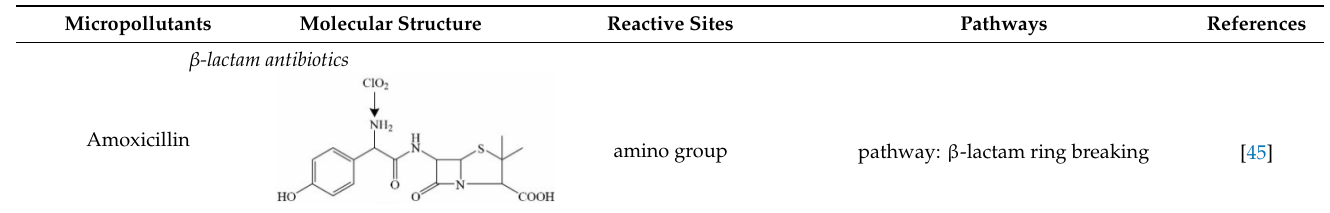
Table 2. Reactive sites and degradation pathways based on the intermediate products in the reaction of ClO 2 with